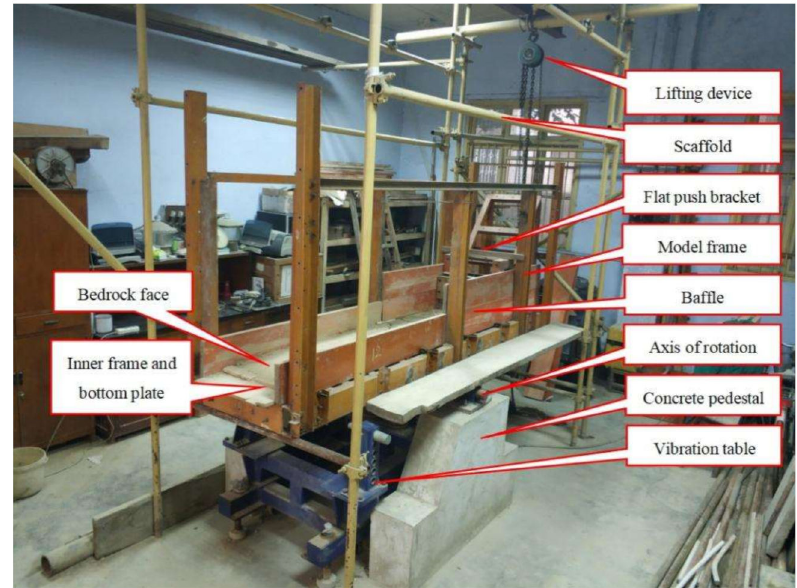
Figure 4. Model test